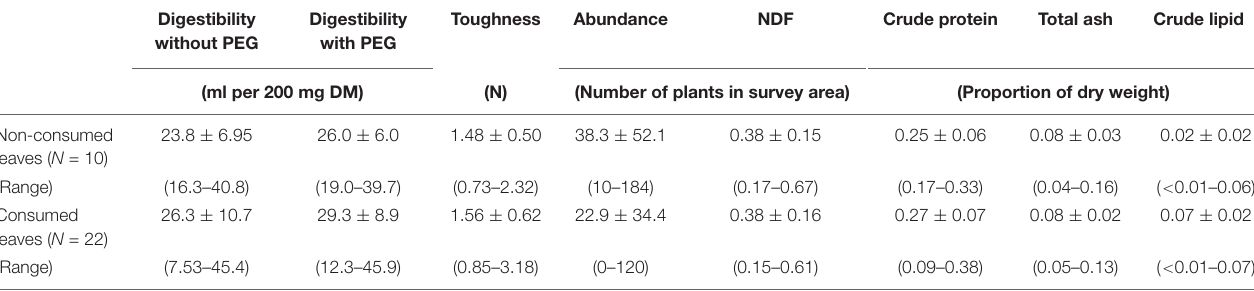
TABLE 3 | Leaf traits and digestibility [mean ± standard deviation] of the young leaves from abundant trees in the study site, with respect to guereza preferences. Digestibility without